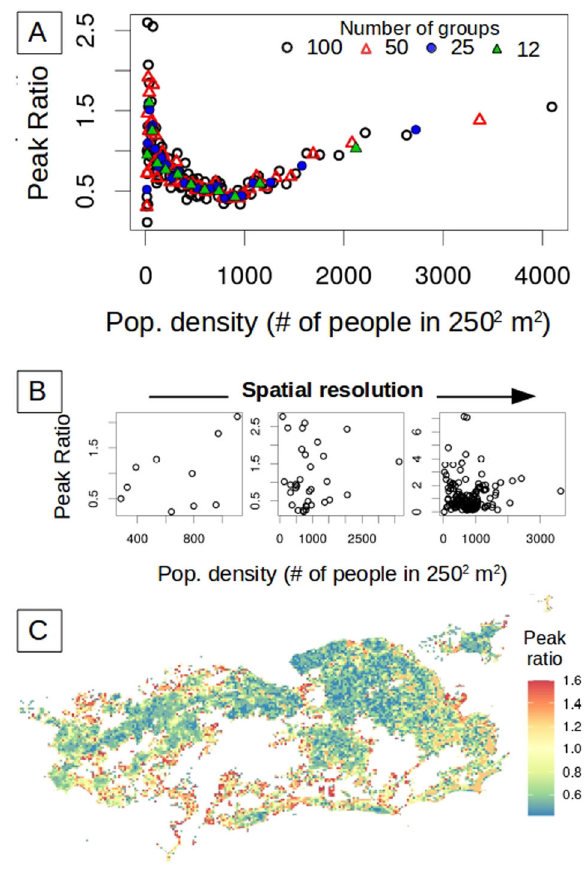
Fig. 2 Ratio between the size of the successive peaks of DENV4. The ratio for the size of the second epidemic over the fi rst one was computed for each spatial location given different resolutions and the two different ways to aggregate space. In ( A ), the 250 m by 250 m units are aggregated according to their population density. In this case, the peak ratio exhibits a clear but nonlinear relationship with human density (see Supplementary Fig. 8D for a log scale representation). The colors correspond to partitions of the city into different numbers of groups. The pattern is invariant to the number of groups (resolution). In ( B ), space is subdivided according to the typical geographical partition into administrative units based on contiguous space. The city of Rio de Janeiro is administratively subdivided into different resolutions, namely 10 or 33 administrative regions (Fig. 1B and Fig. S7B, respectively) and 160 neighborhoods (Supplementary Fig. 7C). For any of these partitions, no relationship is observed between peak ratio and population density, as illustrated here for the three spatial scales of established administrative subdivisions of the city (from left to right: 10, 33, and 160 regions). In ( C ), the heterogeneity in peak ratio across the city is illustrated at the fi nest spatial resolution. The peak ratio spans a range of values, from below to above one (from blue to red), corresponding, respectively, to locations with a second peak smaller than the fi rst one, and vice-versa. This fi ne-scale heterogeneity in peak ratio across space re fl ects that of population density (Supplementary Fig. 6).